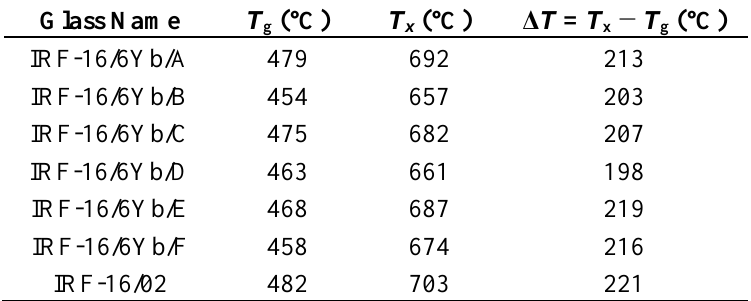
Table 2. Transition temperature ( T stability (Δ T ) of